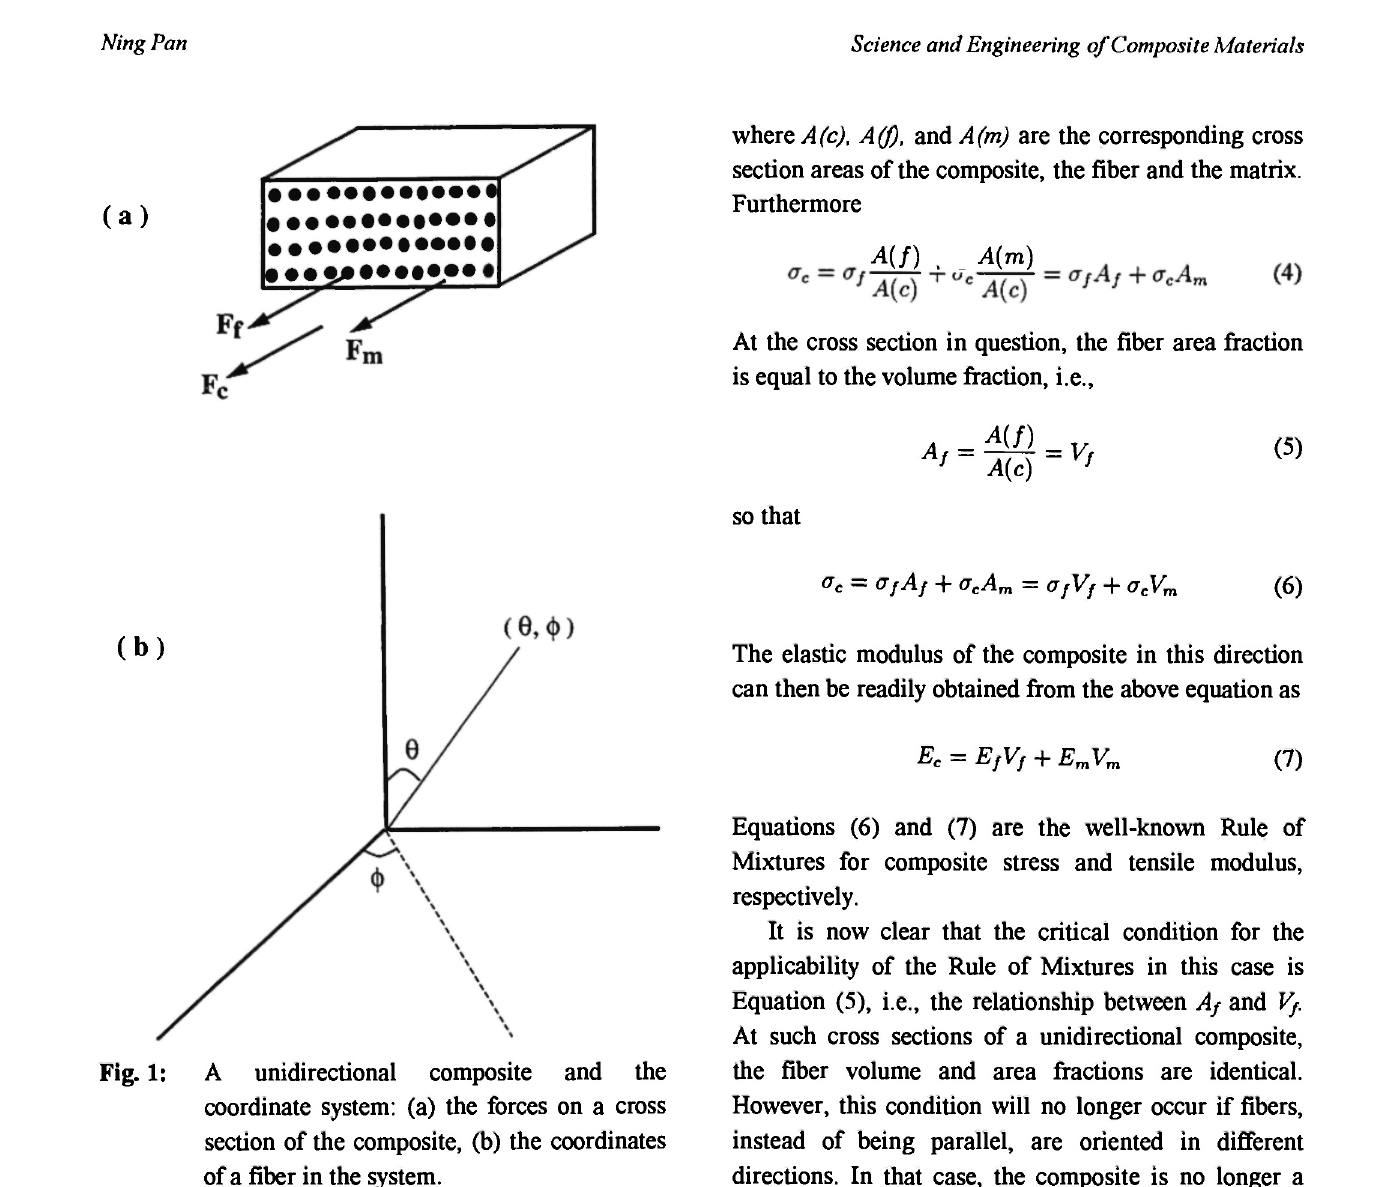
Fig. 1: A unidirectional composite and the coordinate system: (a) the forces on a cross section of the composite, (b) the coordinates of a fiber in the